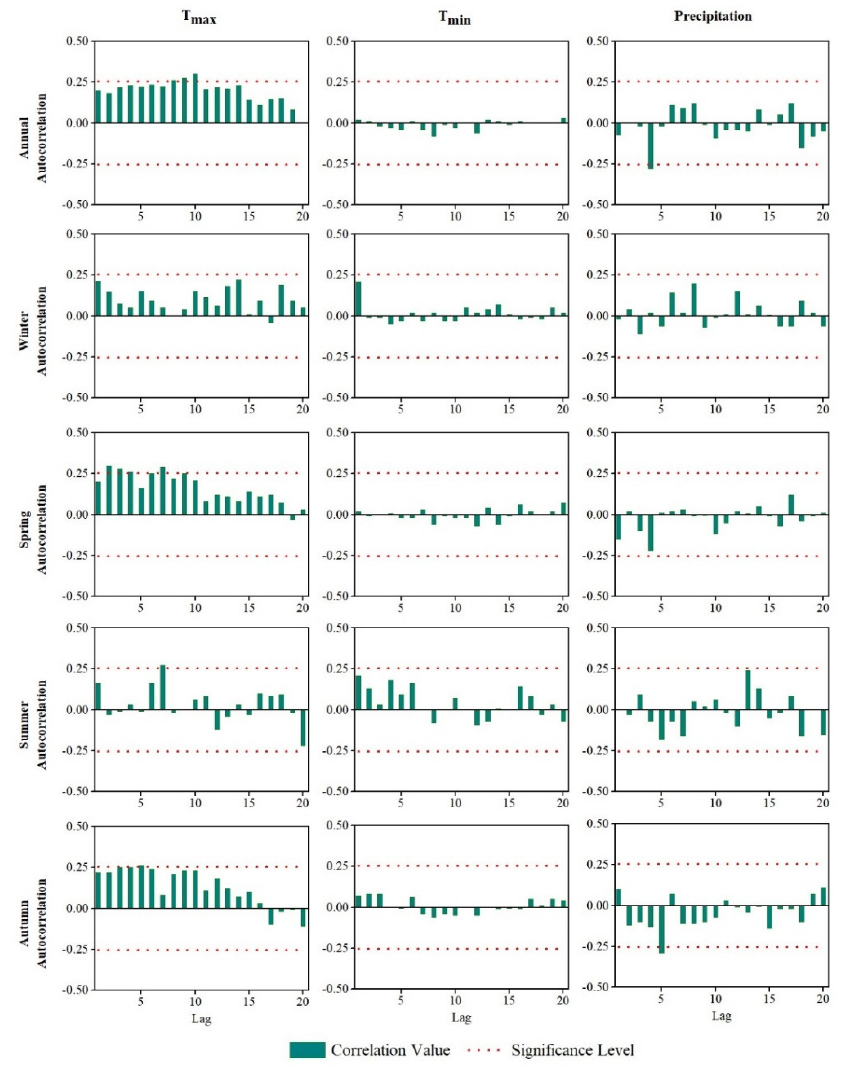
Figure 2. Autocorrelation of annual and seasonal time series for T max , T min and precipitation.